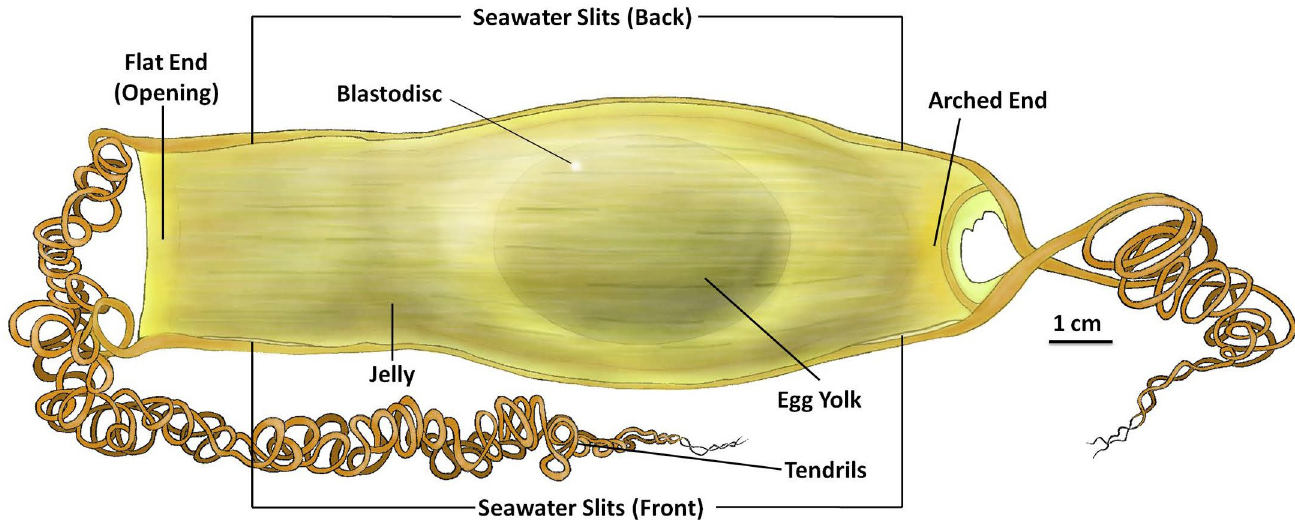
Fig 1. External features of the S . stellaris egg case at stage 1. The internal ellipsoid egg yolk and blastodisc visible at stage 1 of development. The egg case membrane was filled with jelly surrounding the yolk. There were four seawater slits located at each corner of the egg case, two can be seen from the front (as shown in Fig 1), and another two at the back of the egg case (not shown). The flat end of the egg case will be the site of opening during hatching, whereas the arched end remains firm and closed during hatching. There are four tendrils attached at each corner of the egg case. The key feature for stage 1 was no visible embryo on top of the egg yolk. See S1 File for original photographs of Fig 1